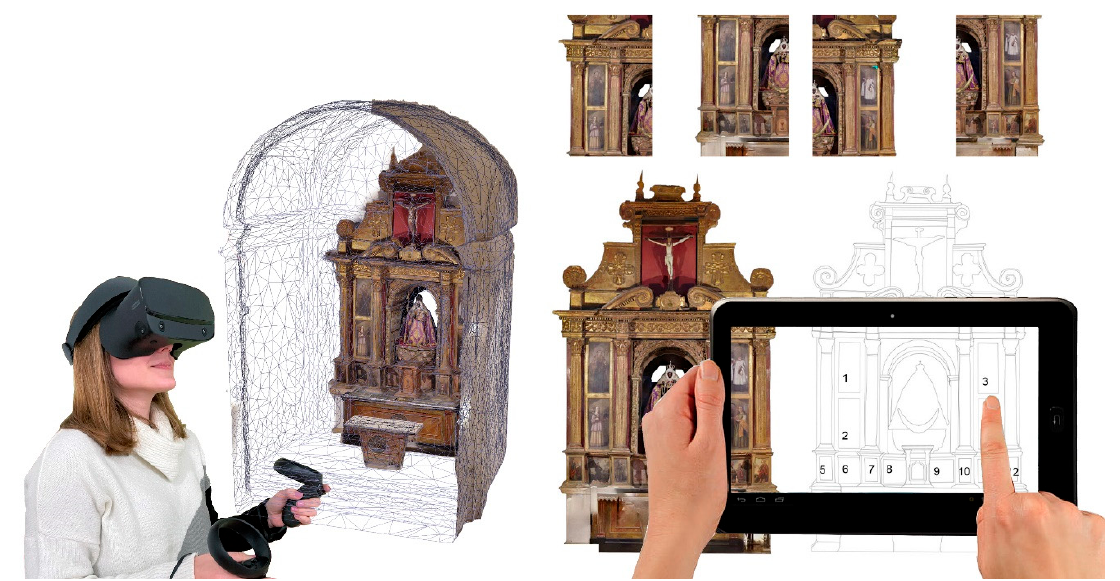
Figure 24. Virtual reality and augmented reality visualizing the altarpiece of the Vaquero Her- mitage.